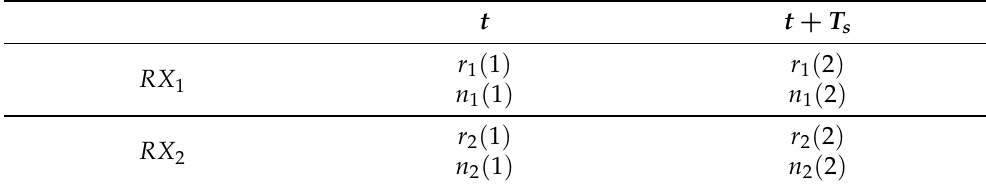
Table 3. Received signal r and additive white Gaussian noise (AWGN) signal n